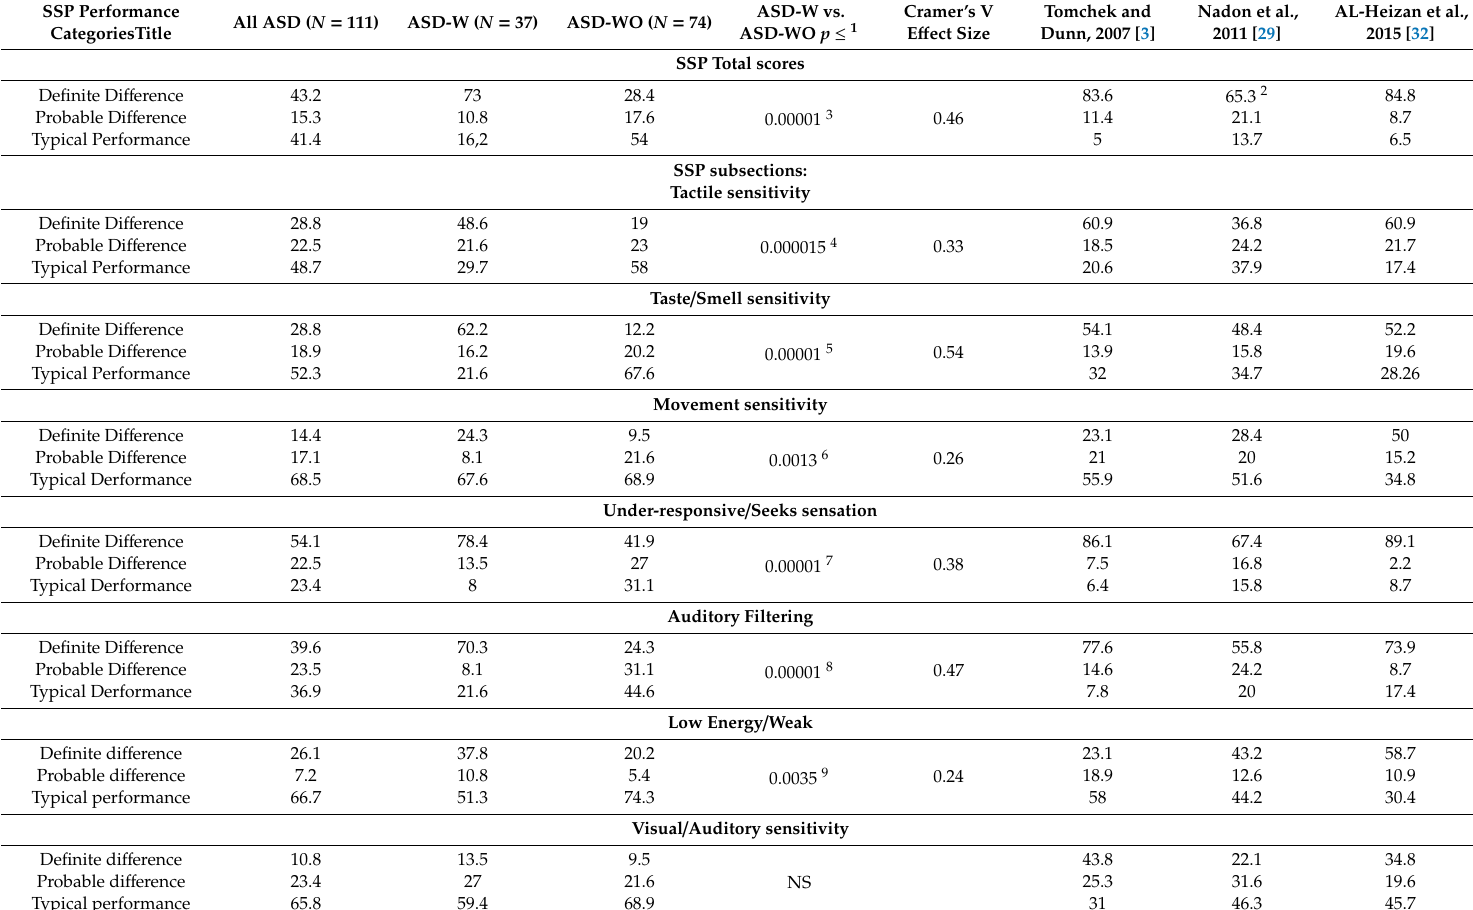
Table 3. SSP performances from the whole ASD sample and from each of the ASD-W and ASD-WO subgroups (expressed as percentages of children); statistically significant di ff erences between ASD-W and ASD-WO subgroups; percentages of children as reported in other studies. SSP Performance